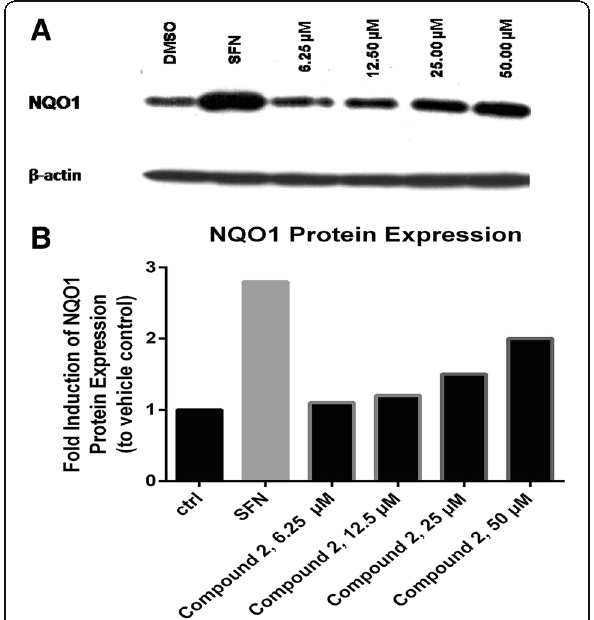
Fig. 5 Concentration -dependent upregulation of NQO1 protein expression by Compound 2 in Hepa1c1c7 cells. Cells were cultured and assayed using Western blotting ( a ) as described in the Experimental section. Densitometric determination ( b ) of the fold of NQO1 induction over DMSO control (ctrl) was performed using Image Studio